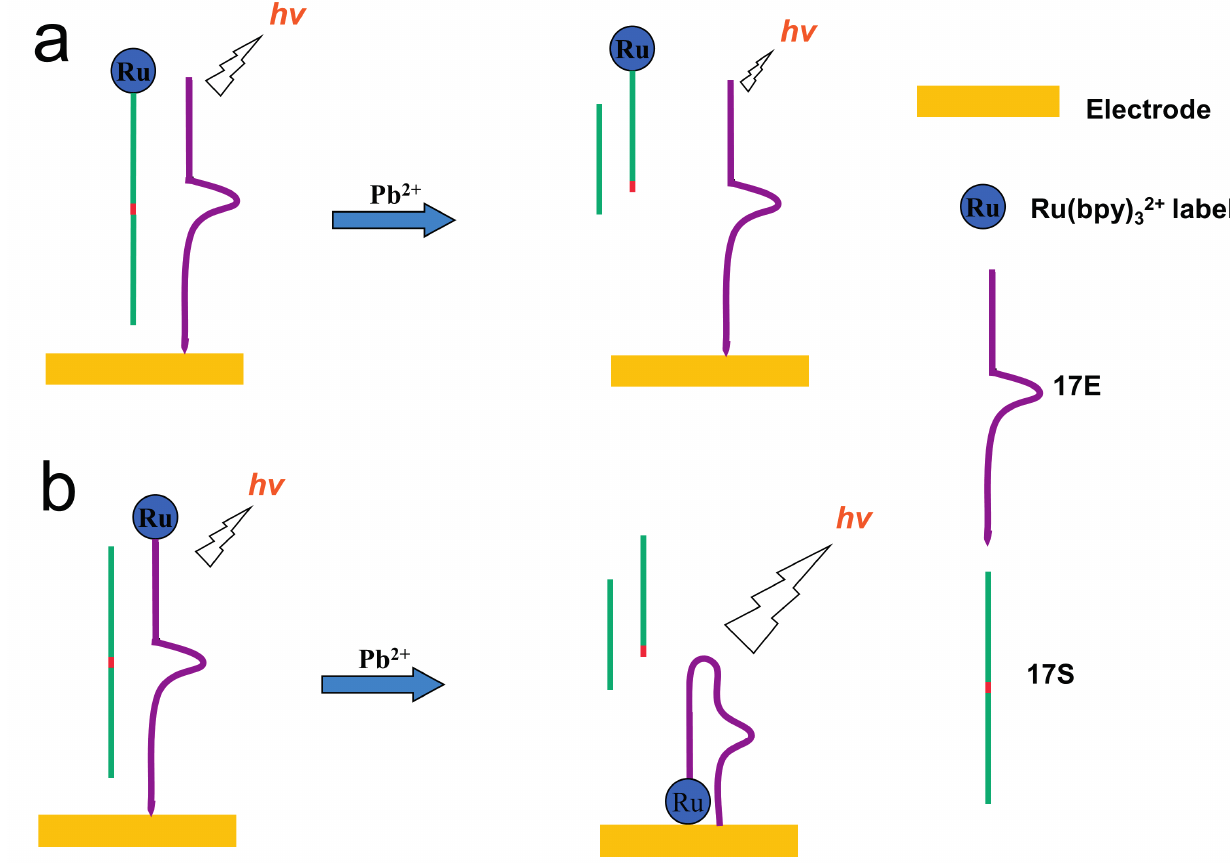
Figure 15. DNAzyme based lead ions detection using as Ru(bpy) 32+ as ECL luminophore. ( a ) signal-off strategy; ( b ) signal-on strategy. ( a ) adapted with permission from ref. [207], copyright (2009) Royal Society of Chemistry; ( b ) adapted with permission from ref. [208], copyright (2011)